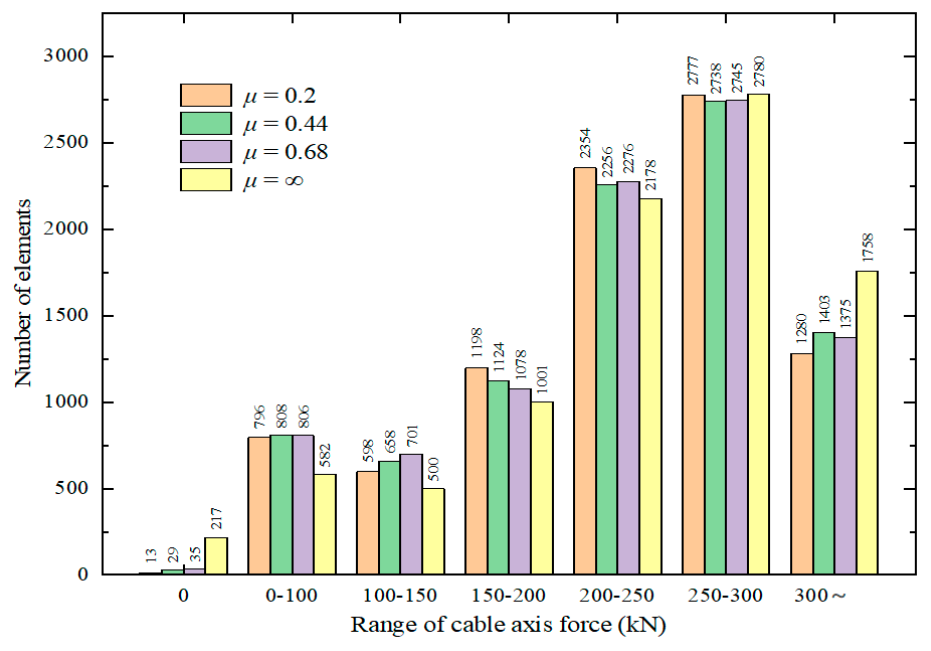
Figure 12. Cloud chart of cable net axial force (unit: N): ( a ) μ = 0.2; ( b ) μ = 0.44; ( c ) μ = 0.68; and ( d ) μ = ∞ *.